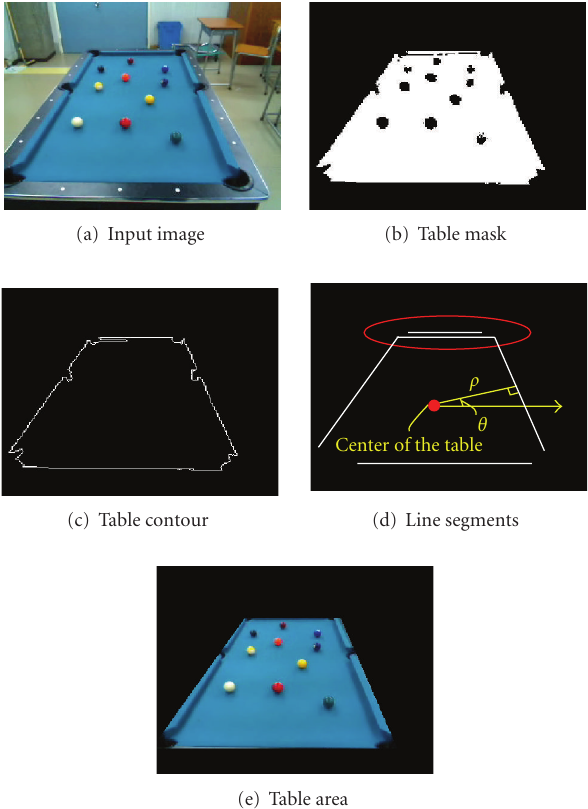
Figure 3: Extraction of four